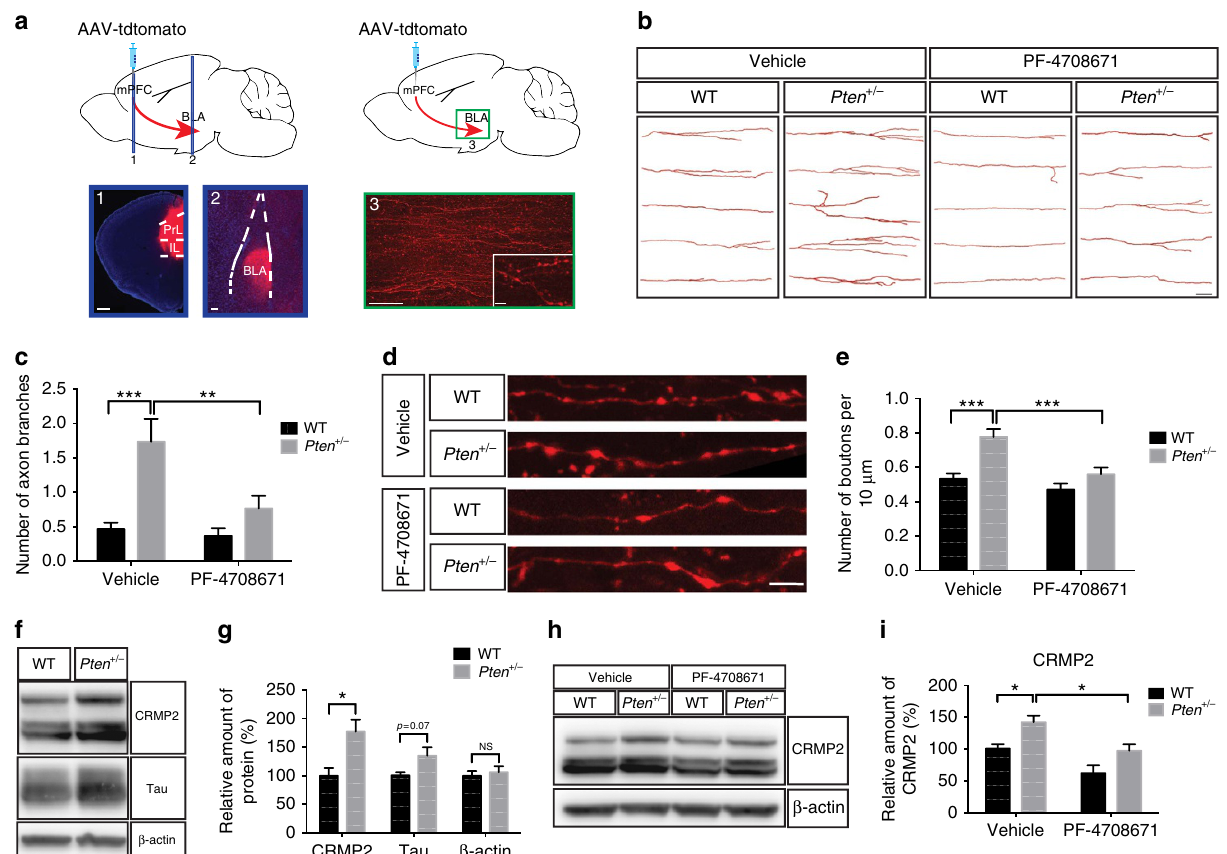
Figure 3 | Hyperconnectivity of mPFC to BLA circuit in Pten mutant mice is corrected by inhibition of S6K1 during development. ( a ) Images showing tdTomato expression in coronal sections of mPFC and basal lateral amygdala (BLA), and sagittal section showing mPFC-originating axon terminals and synaptic boutons in the BLA. Scale bar, 500 m m (1), 100 m m (2), 50 m m (3) and 5 m m (right bottom image of (3)). ( b , c ) Representative images ( b ) and quantification ( c ) of reconstructed mPFC axon terminals in the BLA of adult WTand Pten þ / (cid:2) mice receiving either vehicle or PF-4708671 from